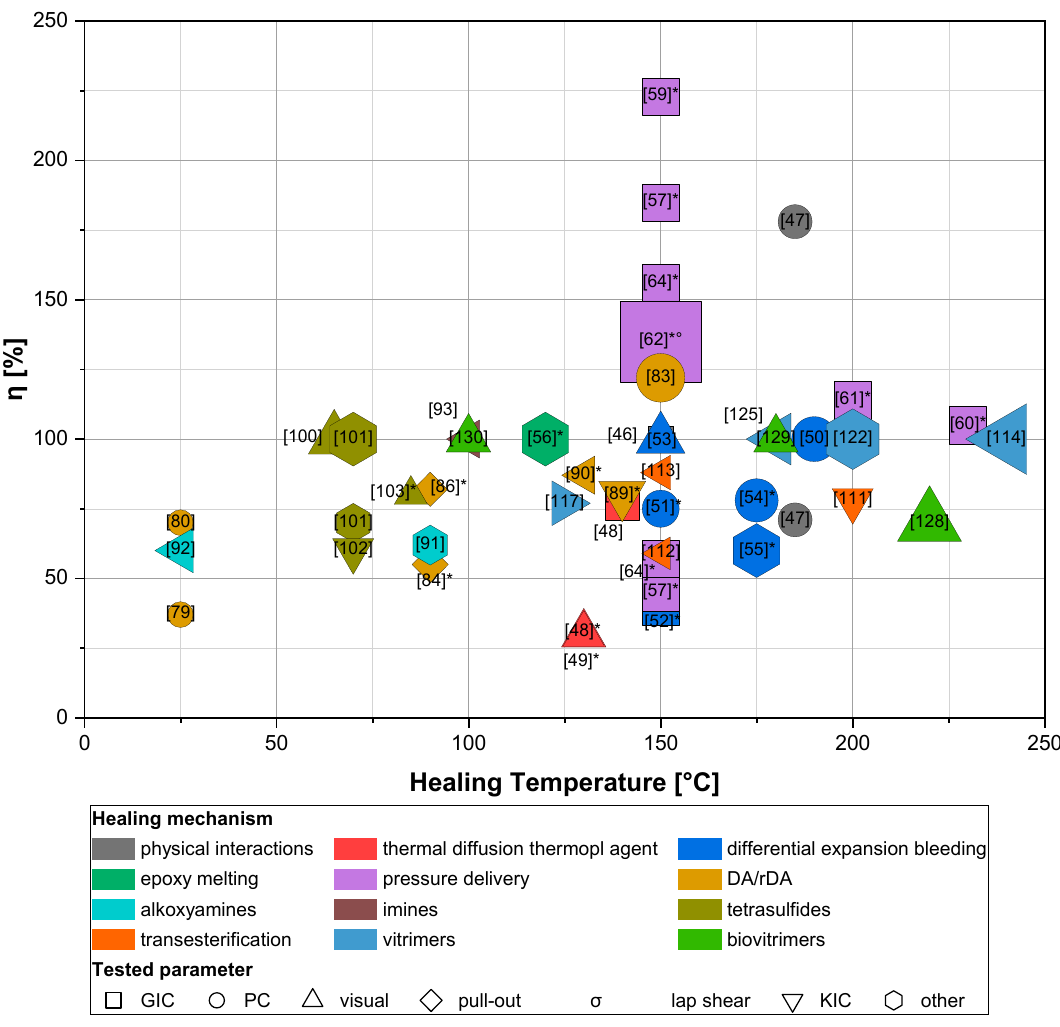
Figure 9. Graphical representation of the intrinsic self-healing formulations described in this review in terms of healing temperature and healing efficiency, with color coding for healing mechanism, shape coding for tested parameter adopted for assessing healing efficiency, and area inversely correlated with healing time (i.e., bigger area = shorter times). If ‘*’ next to [ref.] is present, it indicates that the material is a composite. Otherwise, it is an epoxy as a standalone.